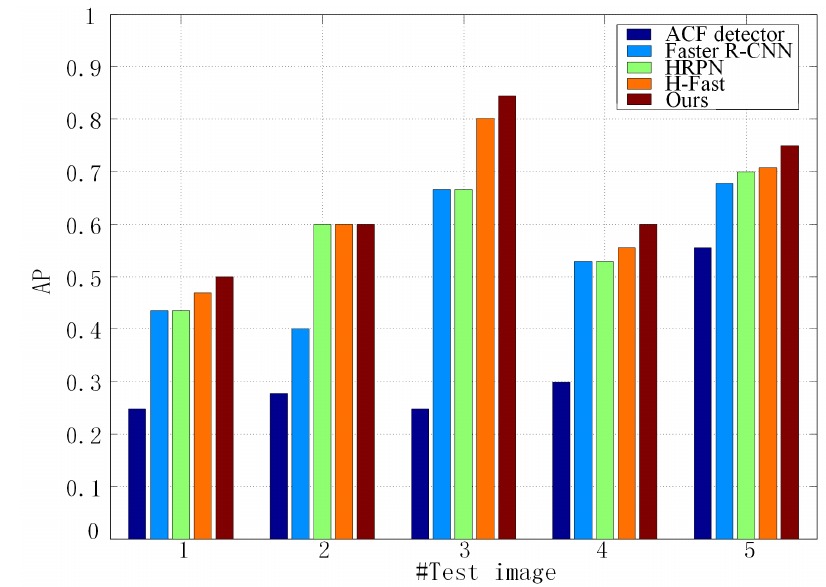
Figure 11. Performance comparisons of different methods in terms of AP values for the collected vehicle